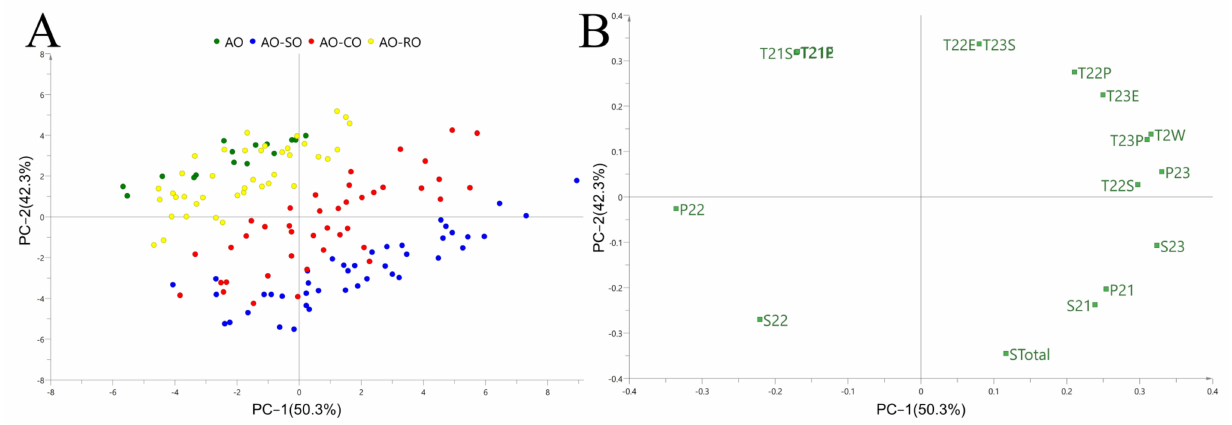
Figure 2. The PCA score plot ( A ) and loading plot ( B ) to distinguish pure AO from adulterated